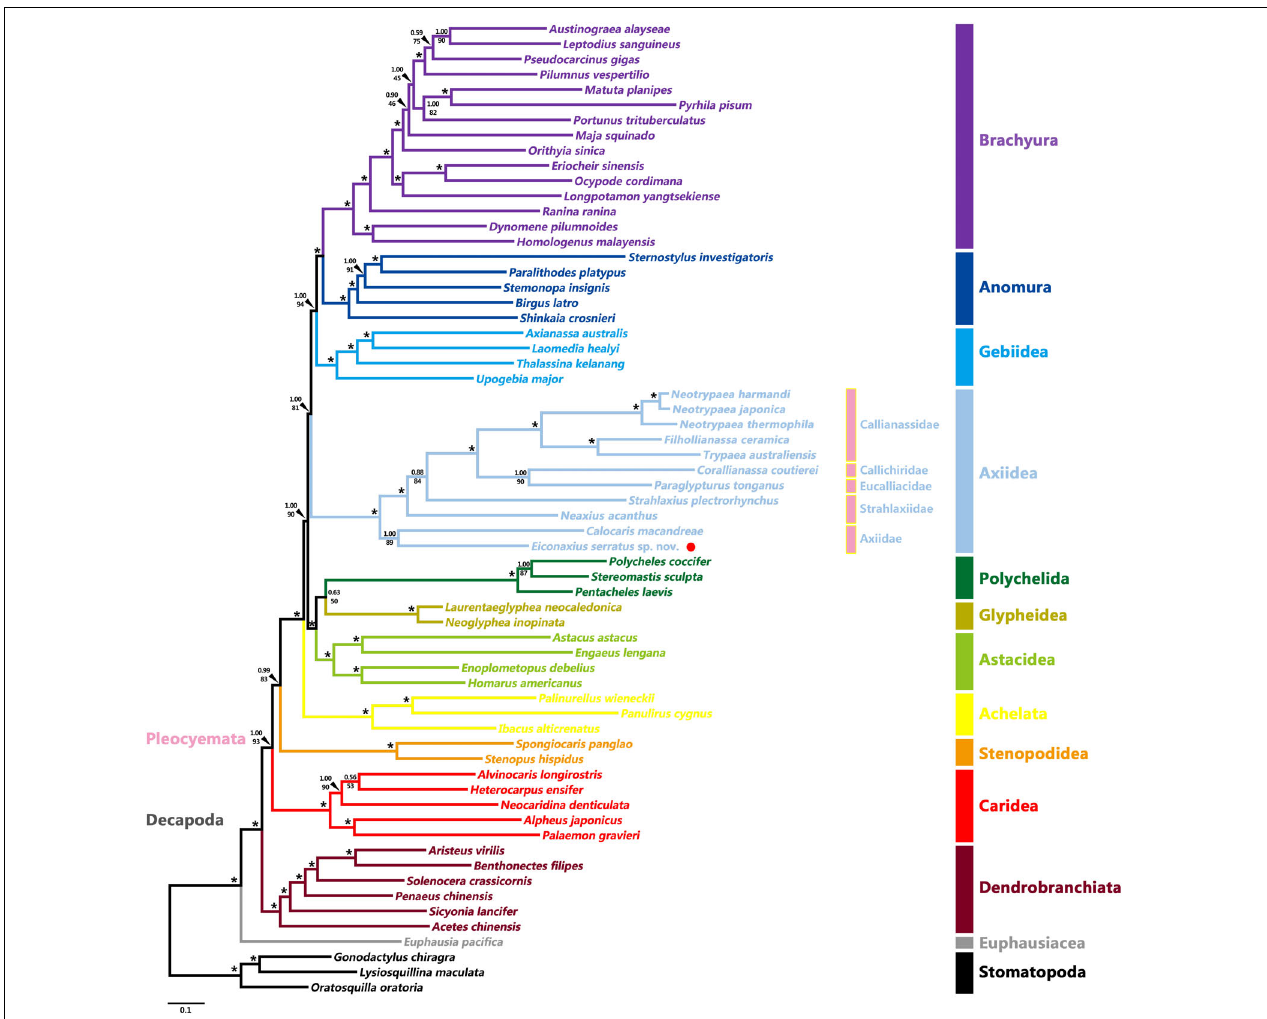
FIGURE 8 | Maximum likelihood tree inferred from the concatenated 13 mitochondrial PCGs nucleotide sequences partitioned by gene. Nodal supports are denoted on the corresponding branches, and the black asterisk (*) indicates both BS and aBayes test value ≥ 0.95 for the